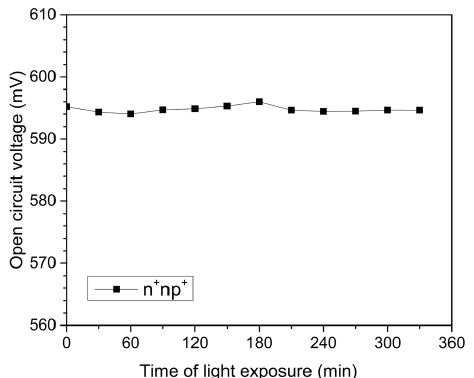
Figure 7. Open circuit voltage of a n + np + thin solar cell as a function of irradiation time. The device was exposed in a steady sun simulator, set to 1000 W/m 2 (AM